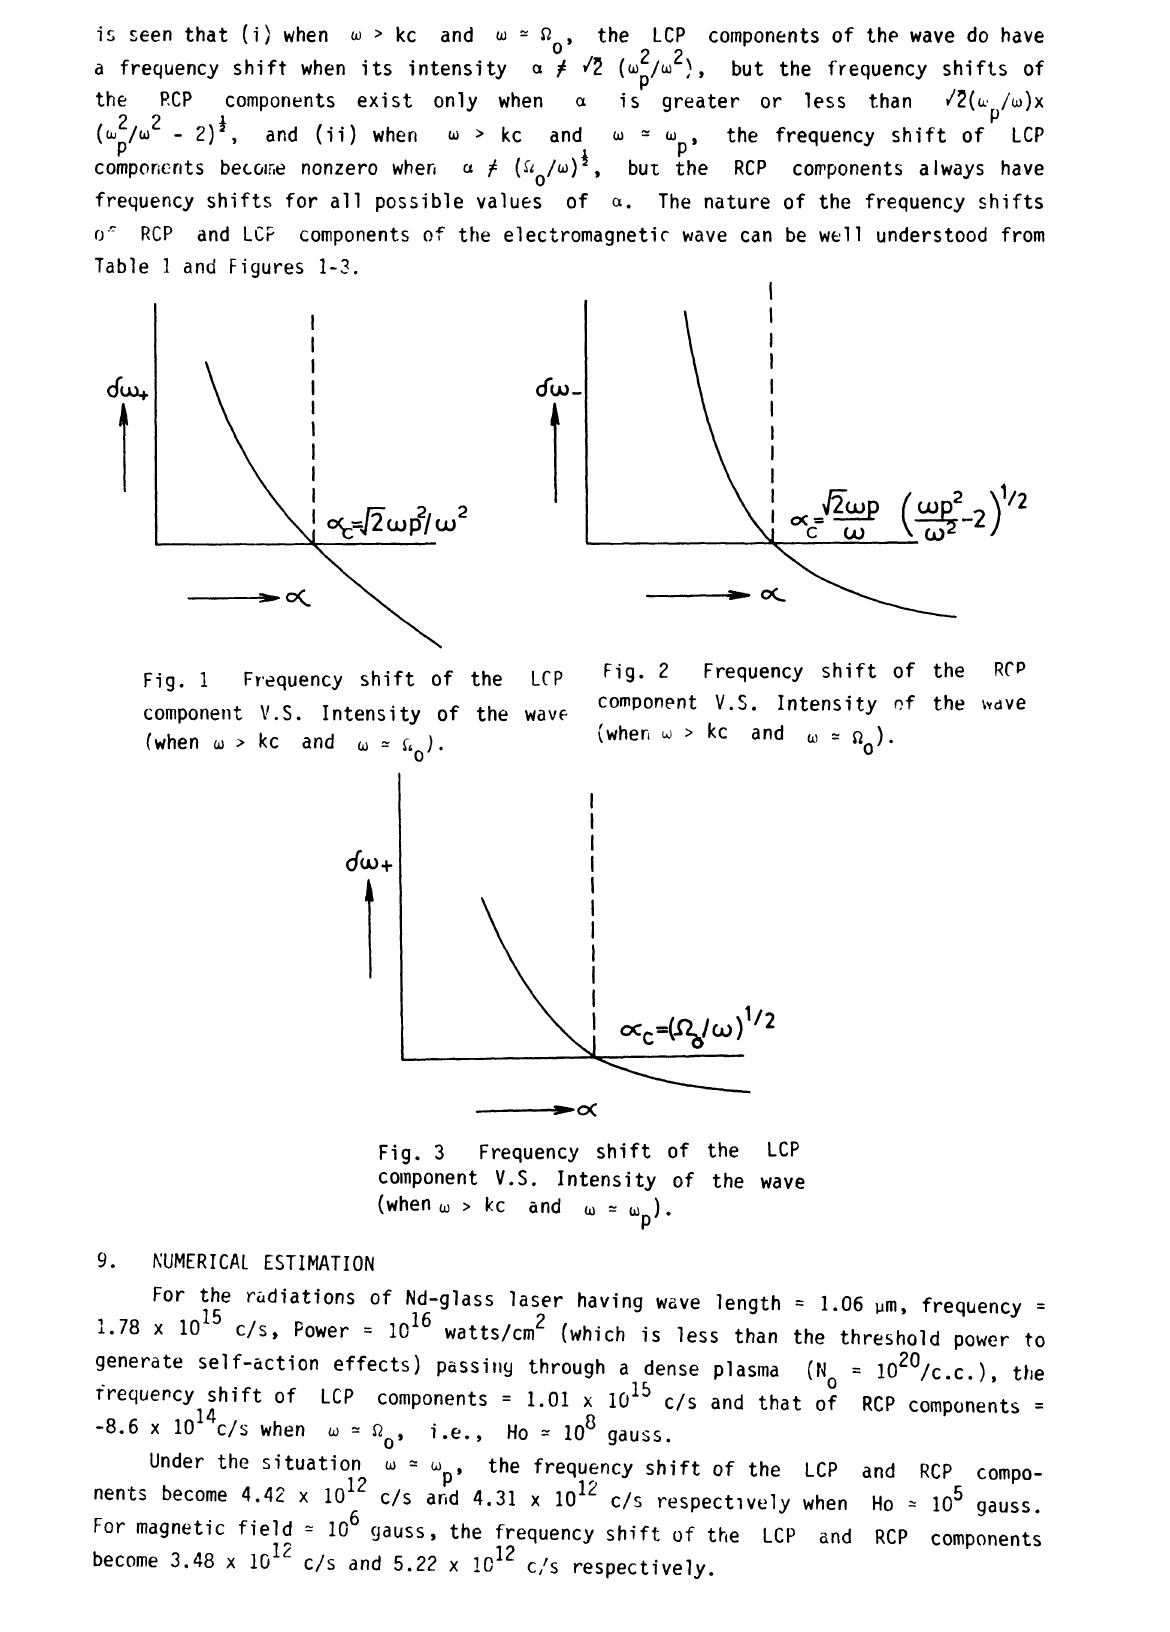
Fig. 3 Frequency shift of the LCP component V.S. Intensity of the wave (whenm > kc